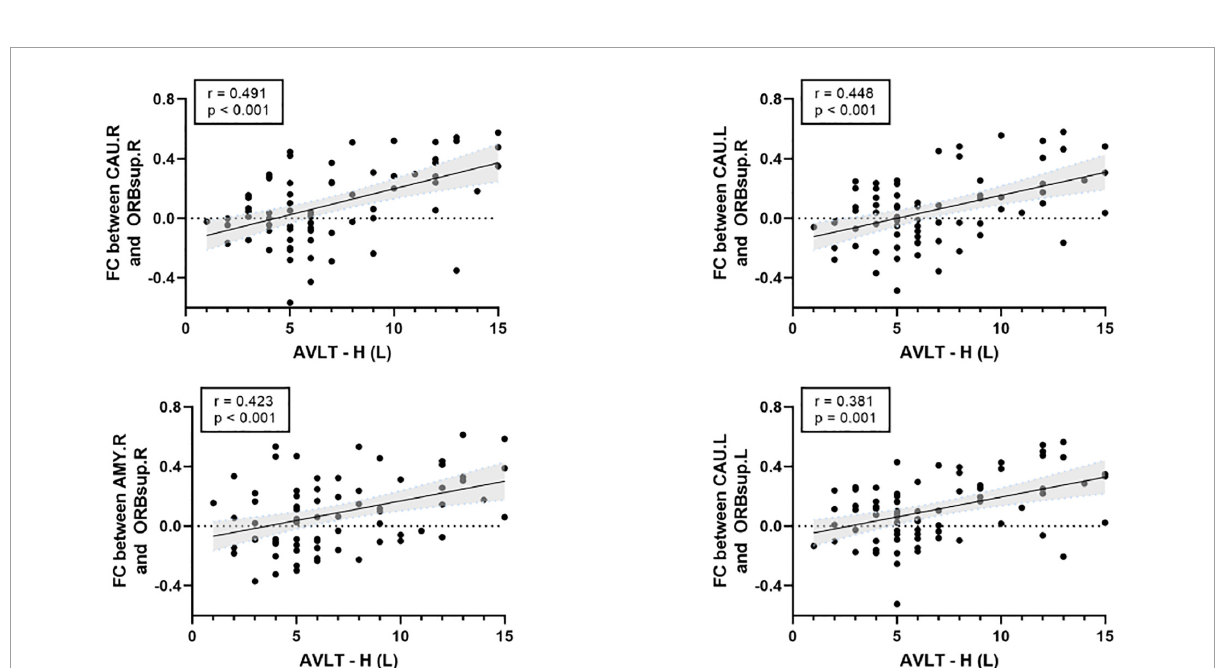
FIGURE4 Correlations between cognitive test score and the functional connectivity between default mode network (DMN) and limbic/subcortical cortex. FC, functional connectivity; AVLT-H (L), Auditory verbal learning test-Huashan version for long term; ORBsup.R, right superior orbitofrontal cortex; ORBsup.L, left superior orbitofrontal cortex; CAU.L, left caudate; CAU.R, right caudate; AMYG.R, right